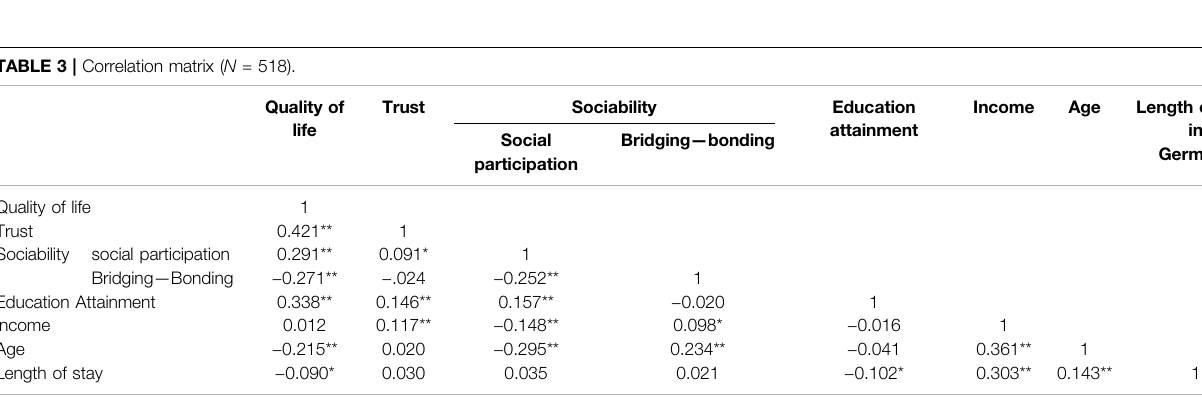
TABLE 3 | Correlation matrix ( N (cid:1) 518).